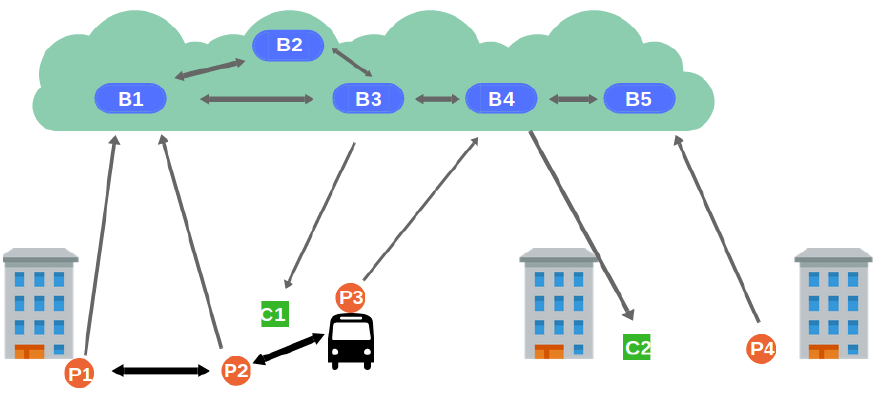
Figure 4. Collaborative